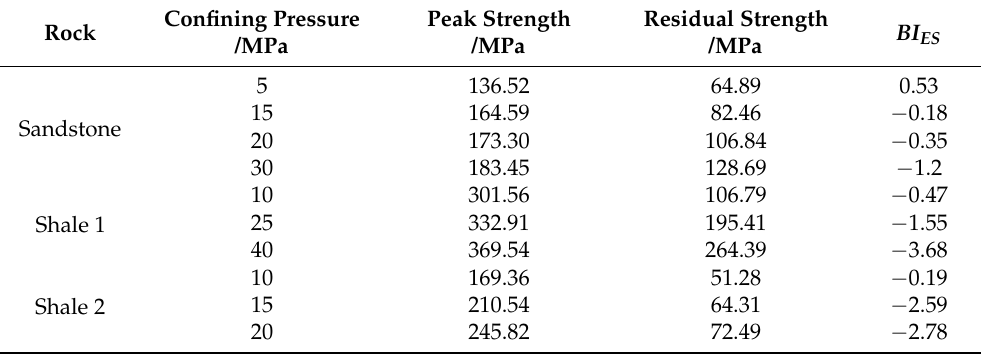
Figure 7. Stress–strain curves of six types of rocks: ( 1 ) Sandstone; ( 2 ) Shale 1; ( 3 ) Shale 2; ( 4 ) Glutenite; ( 5 ) Granite; ( 6 ) Gneiss. Table 6. Results of six types of rocks calculated based on BI ES